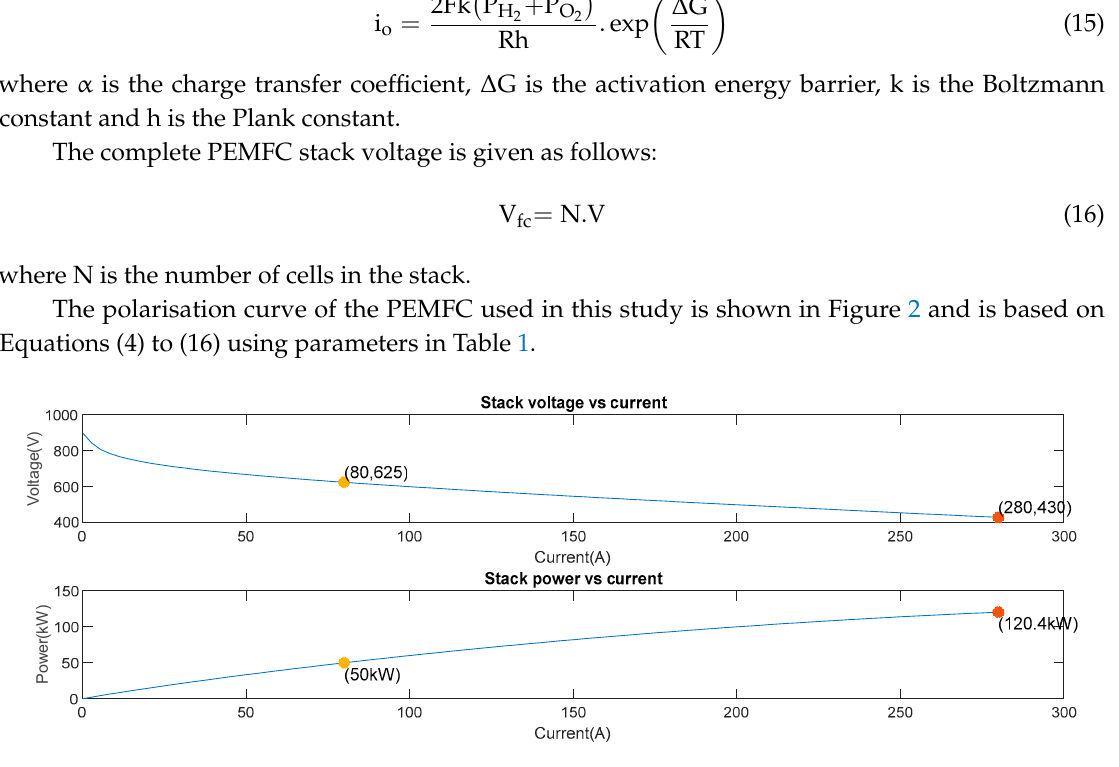
Figure 2. 53 kW PEMFC polarisation curves.